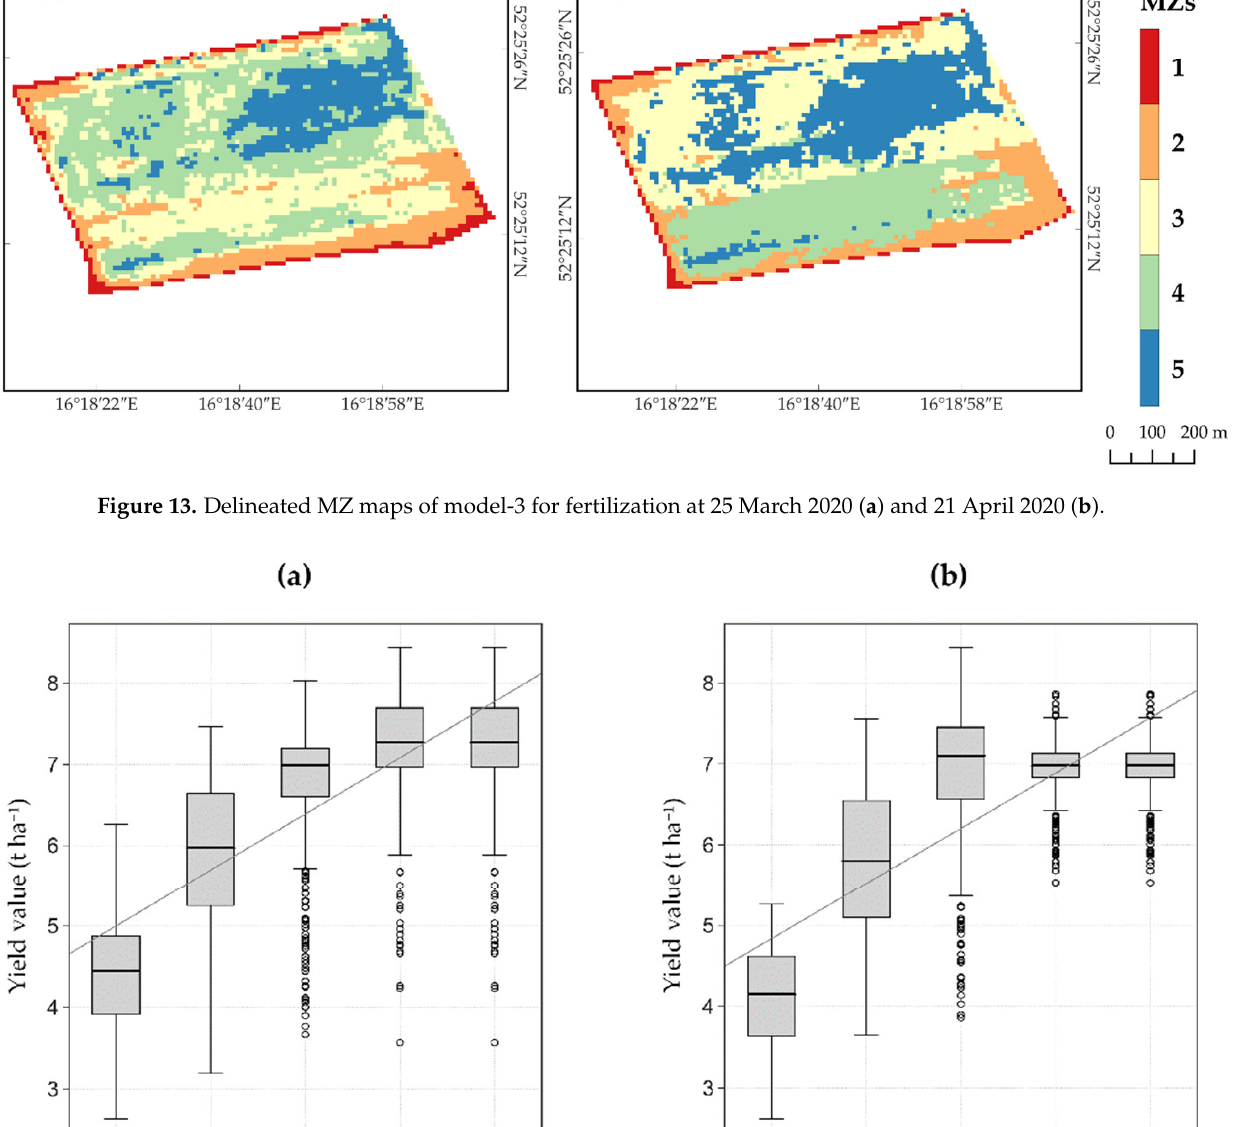
April 2020 ( b ). The white circles out of the whiskers show outliers.